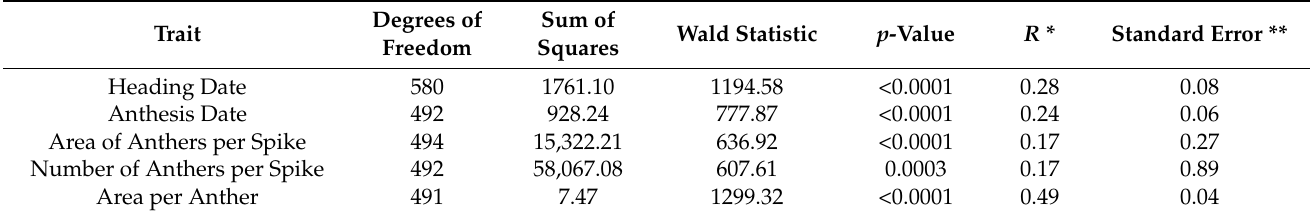
Table 1. Listed summary statistics derived from mixed linear models. p -values are derived from a chi-squared distribution. A p -value of 0.05 or less is considered